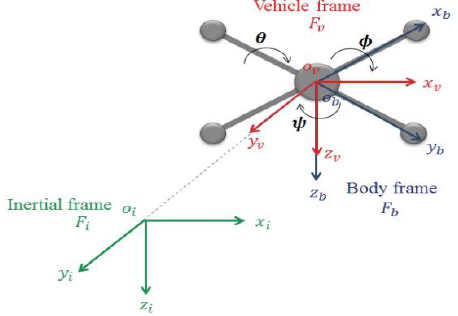
Figure 2. Inertial, body and vehicle frames